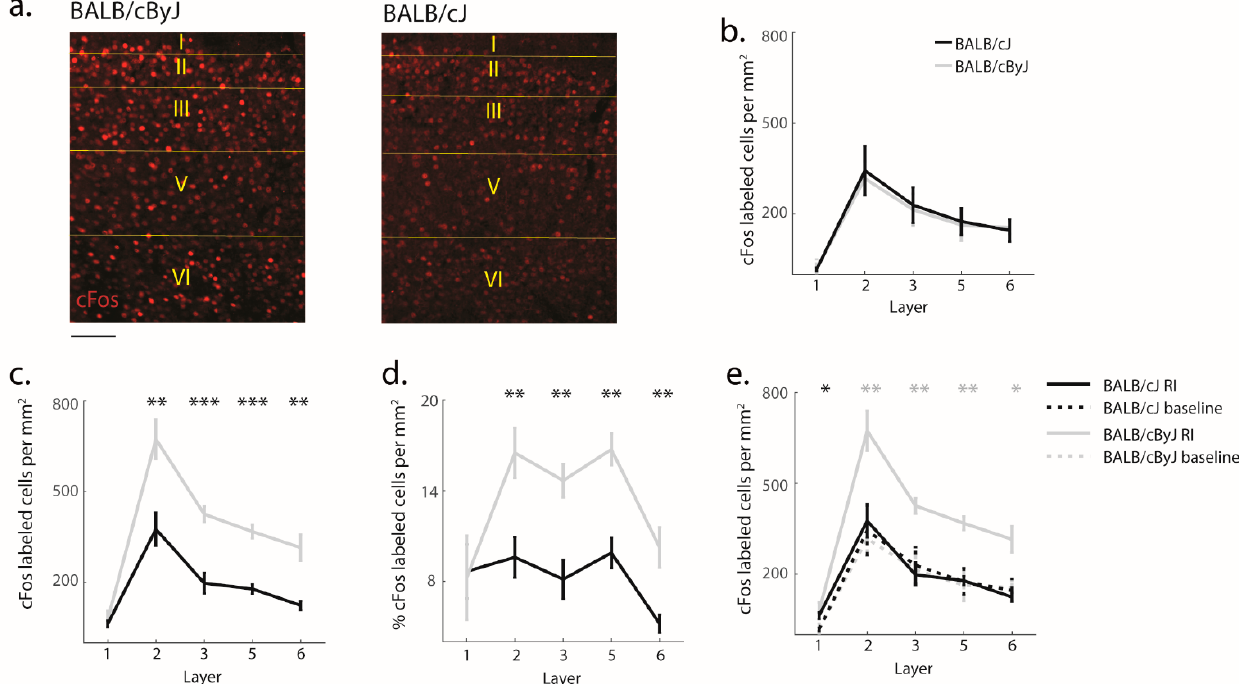
Figure 5. cFos activity levels: ( a ) Example photographs of stained cFos cells in BALB/cByJ and BALB/cJ mice, scale bar: 100 µ m; ( b ) The number of cFos-labeled cells per mm 2 at baseline. Black line, BALB/cJ mice; gray line, BALB/cByJ mice; ( c ) The number of cFos-labeled cells per mm 2 during the last day of the RI test. Asterisks: Statistical significance of comparison between BALB/cByJ and BALB/cJ mice; ( d ) Same as ( b ) but expressed as percentage of total neuron density; ( e ) Comparison of activity at baseline versus RI for BALB/cJ and BALB/cByJ mice, respectively. Gray asterisks: Statistical comparison between baseline and RI test in BALB/cByJ animals. Black asterisk: Same for BALB/cJ; ( b – e ) Show the average and SEM per layer. * p < 0.05; ** p < 0.01; *** p < 0.001.